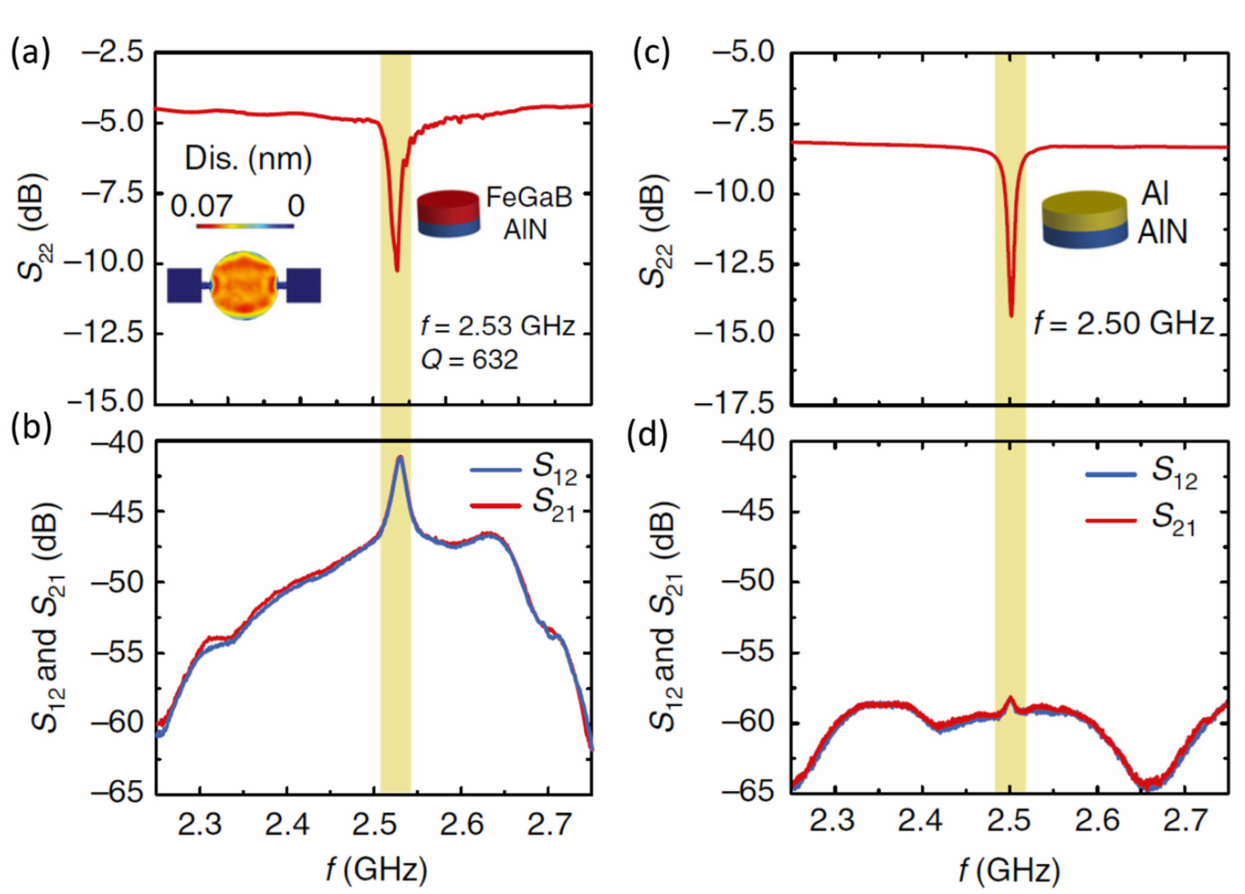
Figure 11. ( a ) Return loss curve ( S 22 ) of ME FBAR. The inset shows the out-of-plane displacement of the circular disk at f r . ( b ) S 12 and S 21 of the ME FBAR. ( c ) S 22 curve of the nonmagnetic Al/AlN control FBAR. ( d ) S 12 and S 21 of the nonmagnetic Al/AlN control FBAR. Reprinted with permission from ref. [47]. Copyright 2021 Springer Nature